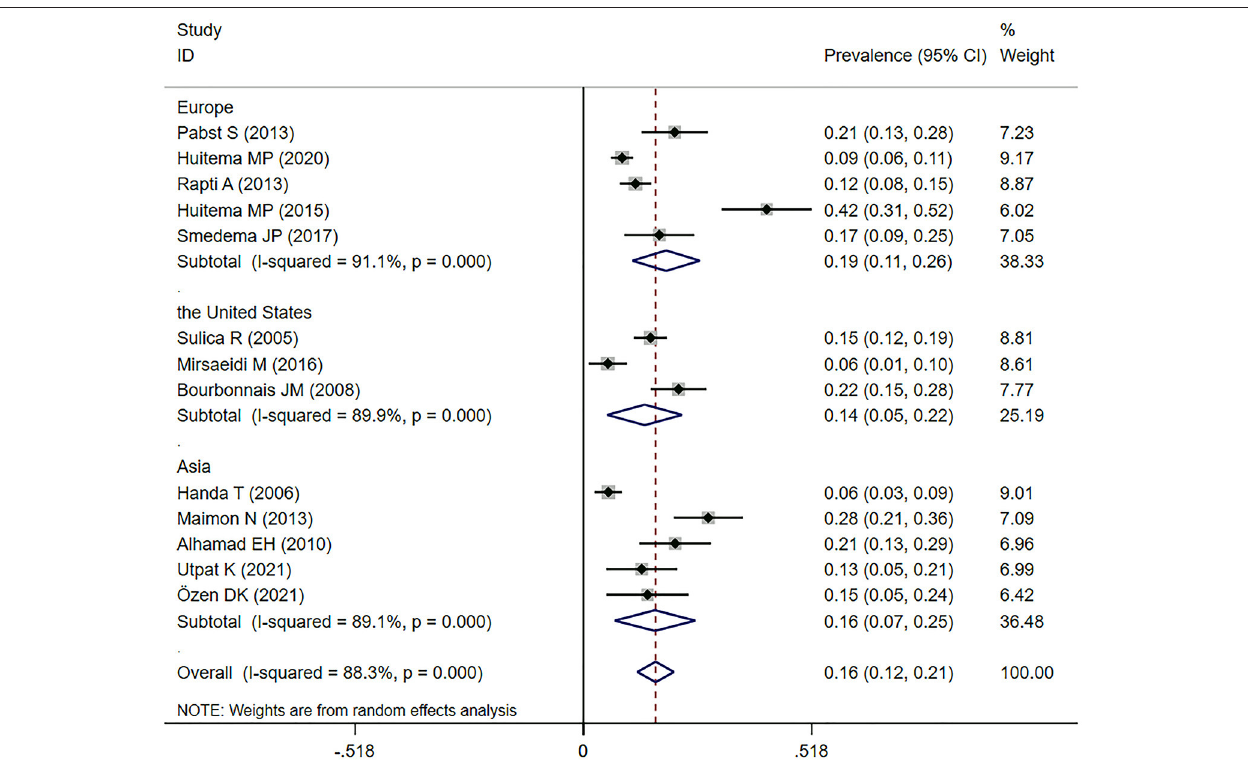
FIGURE 2 | Forest plot of the pooled prevalence of SAPH by TTE in the general sarcoidosis population. SAPH, sarcoidosis-associated pulmonary hypertension; TTE, transthoracic echocardiography.